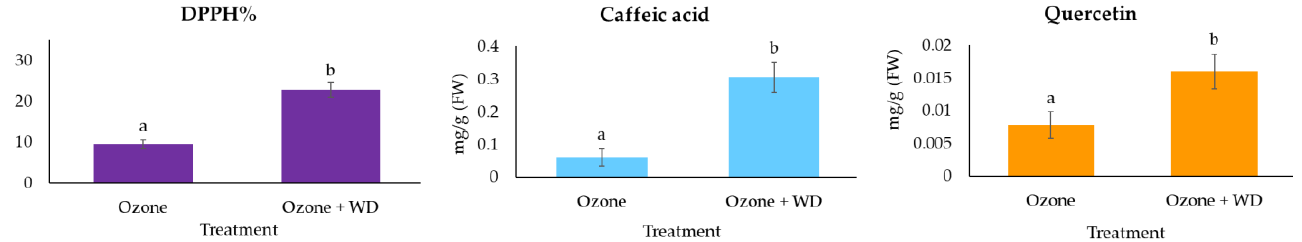
Figure 2. Expression of the antioxidant power (DPPH%) and concentration (mean ± standard error) of both caffeic acid and quercetin in samples of Lactuca sativa after 30 days of fumigation with 60 ppb of O 3 in combination with (Ozone + WD) or without (Ozone) weekly foliar applications of 0.2% chestnut wood distillate (WD). Different letters indicate statistically significant ( p < 0.05) differences between treatments.